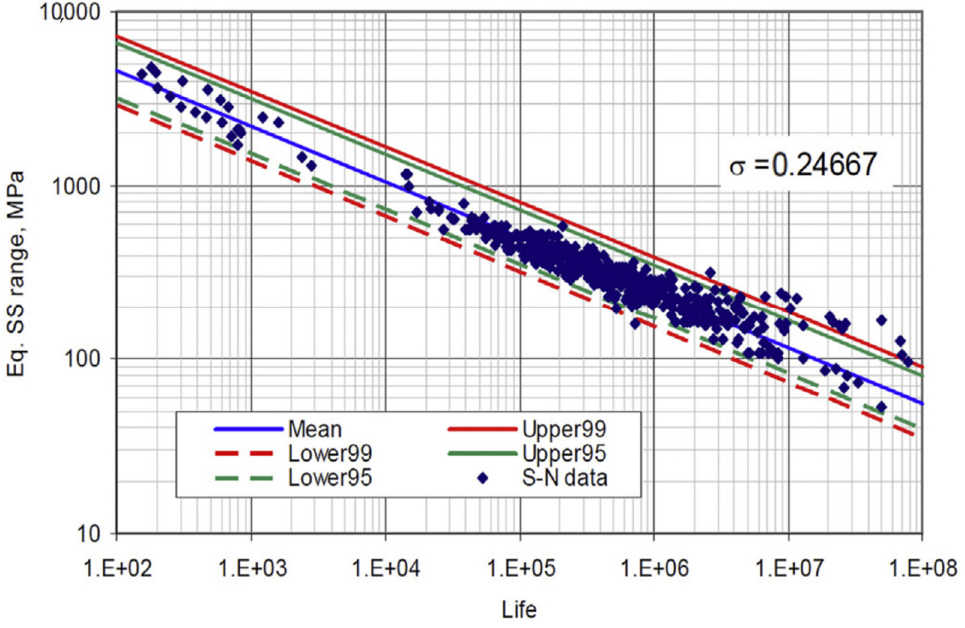
Figure 16. Master S–N curve obtained from Dong’s structural stress